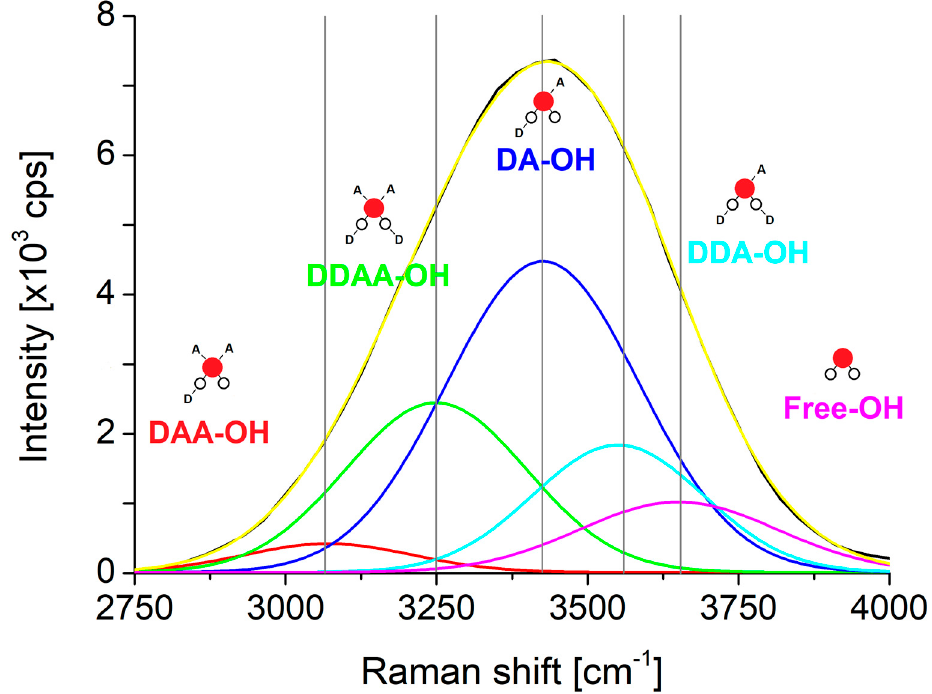
Figure 6. Structure of the typical Raman spectrum in the OH-stretching region of water molecules acting on different levels of proton-acceptors and proton-donors. D—hydrogen donor, A—hydrogen acceptor [26,43].